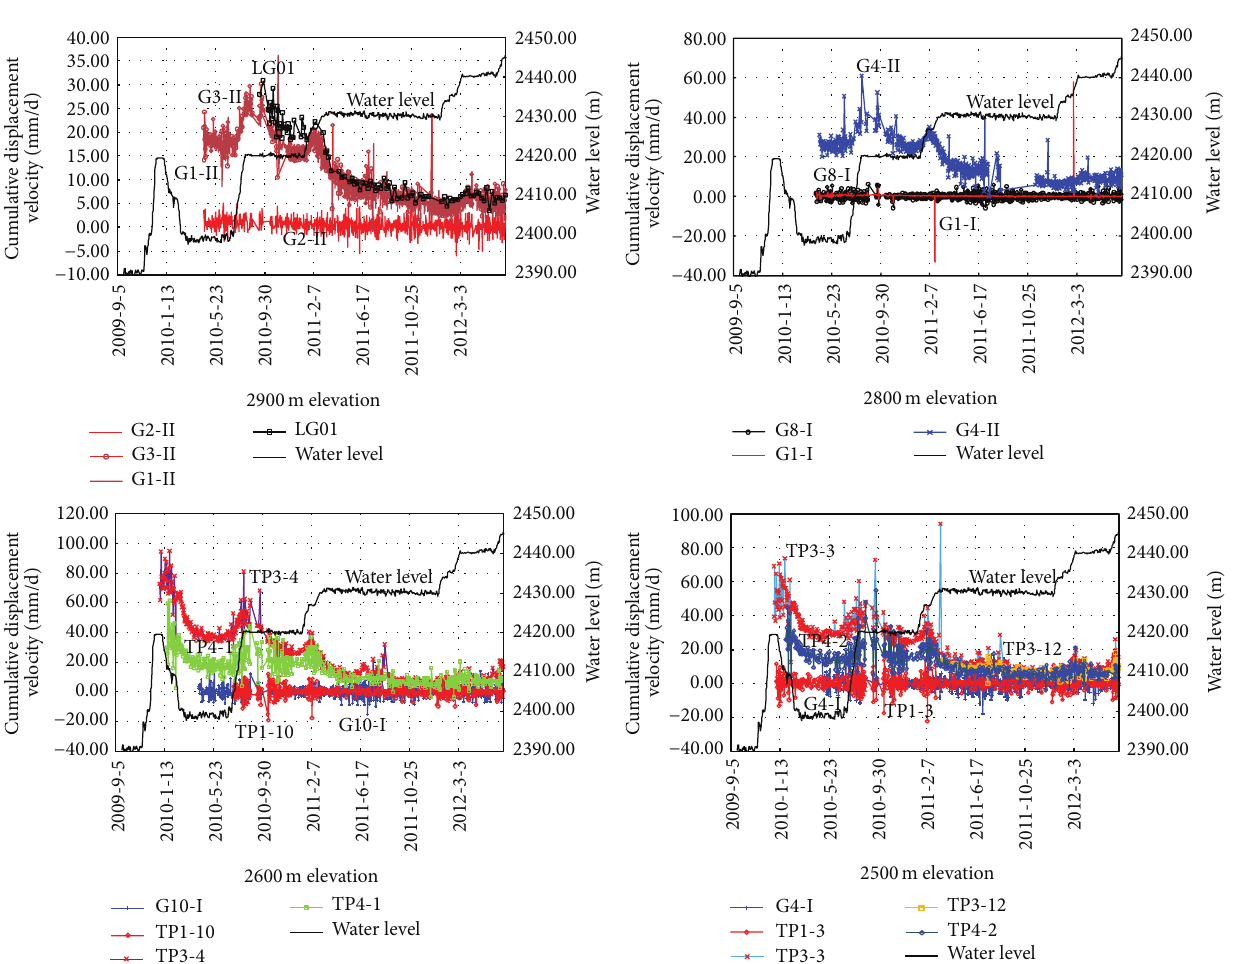
Table 2. The slope geological model is the evaluation base